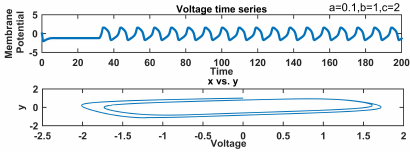
Figure 34. Responses of membrane potential and recovery variables with a = 0.1, b = 0.8, c = 3